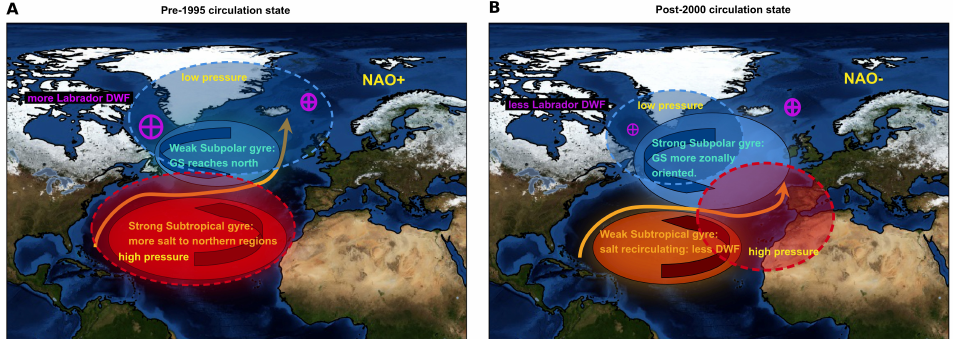
Figure 6. ( A ) Time series for the NAO index, AMOC at 26.5° N from ORAS5 (blue), ORAS4 (red), and SODA (green). ( B ) Lag correlation of the AMOC strength time series of each model vs. annual NAO index. Here, assuming the data are normally distributed with zero mean and unitary variance, the 95% confidence intervals yields that all values above 0.3 are statistically significant. The NAO index is from https://climatedataguide.ucar.edu/climate-data/hurrell-north-atlantic-oscillation- to the standard deviation in time were used, in order to have dimensionless and directly comparable values. It is interesting to note that all products indicate NAO driving AMOC variations with a lead-time close to 5 years.